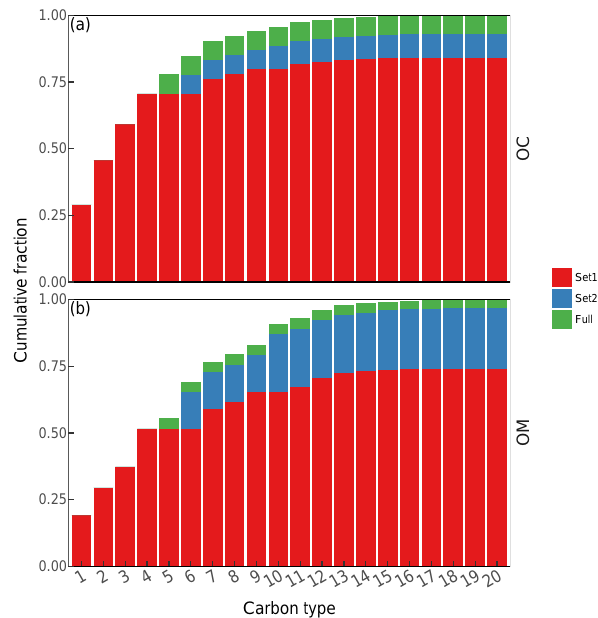
Figure 5. Cumulative carbon fraction for APIN simulation at t max SOA . Colors show carbon atoms measurable by different sets of FGs (Sect. 2.3). The carbon types are defined in Fig.